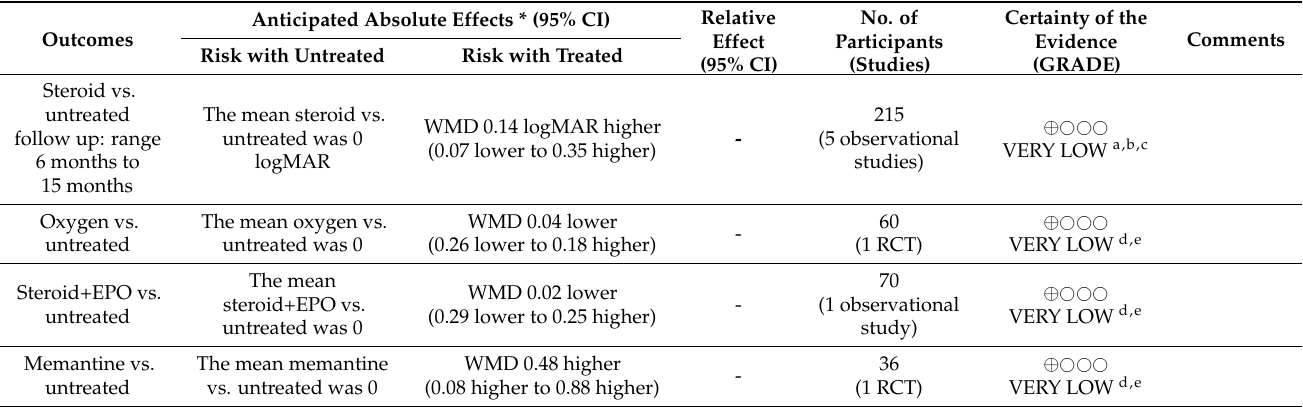
Table 3. GRADE of evidence of our results for visual acuity as a continuous variable.